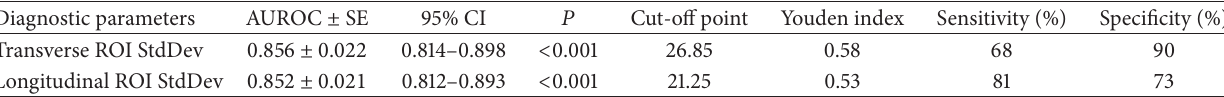
Table 3: Accuracy of quantitative ultrasonic parameters for diagnosing biceps tendinitis.